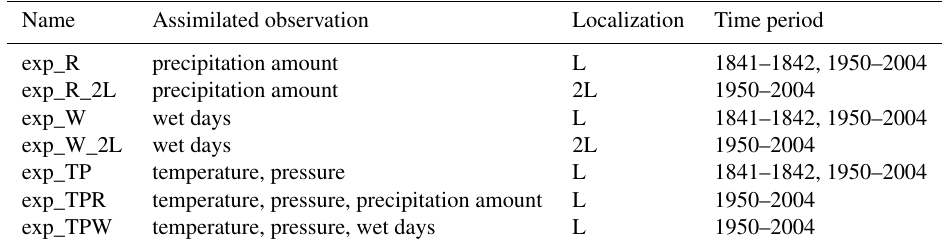
Table 1. Summary of experiments and their